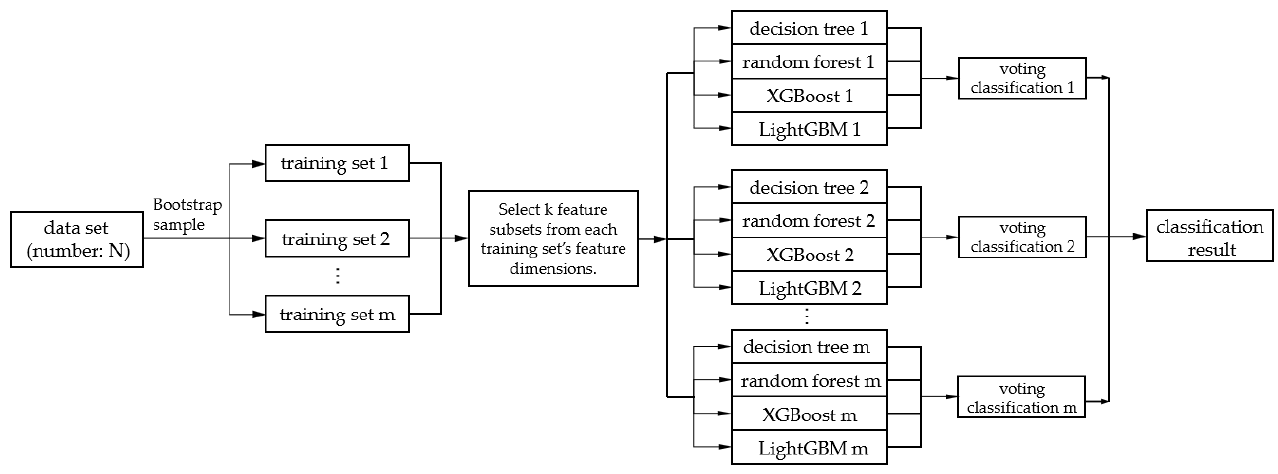
Figure 3. The construction process of bagging fusion model for grade prediction.